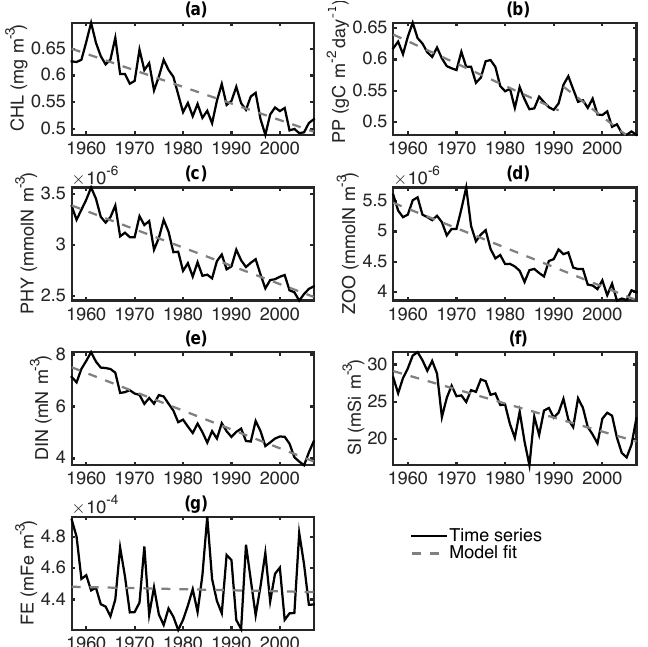
Figure B4. Time series of (a) surface chlorophyll, (b) integrated primary production, (c) total surface phytoplankton, (d) zooplankton biomass and (e) surface dissolved inorganic nitrogen, (f) silica and (g) iron simulated with the PlankTOM10 model and averaged over the Gulf of Alaska region. The dotted lines represent the statistical model selected.